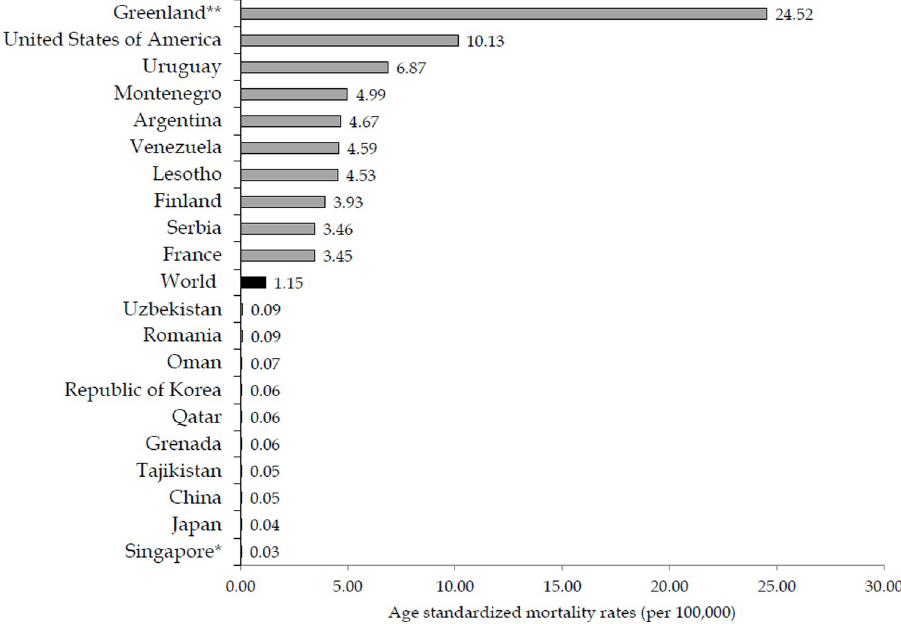
Fig 4. Suicide mortality by firearm in men, by countries: 10 highest / 10 lowest rates in the world in 2019. � Country with the lowest rate; �� Country with the highest rate. Source: GBD estimates [20].